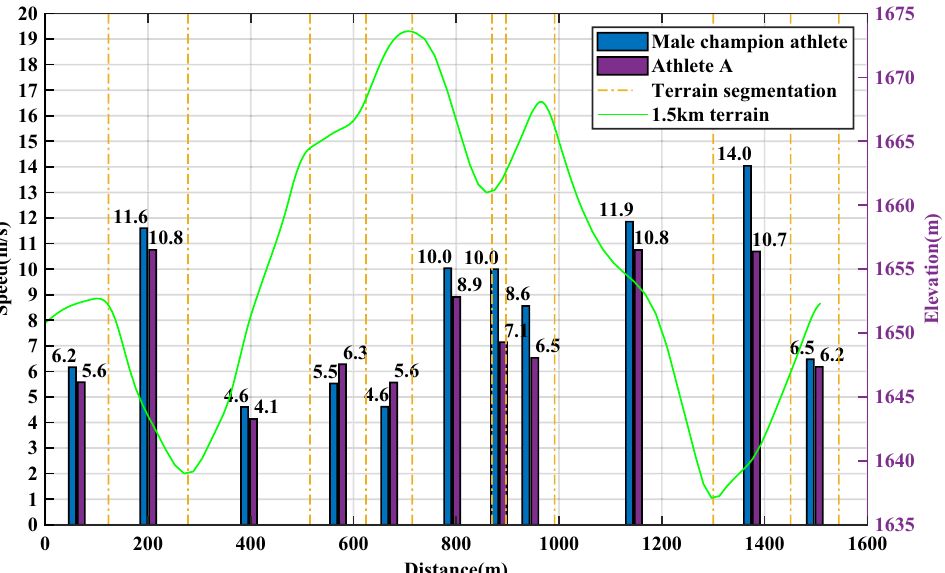
Figure 11. Speed distribution comparison of athlete A and male champion athlete.